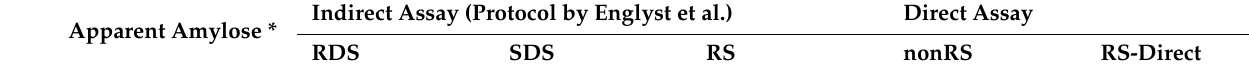
Table 3. Lentil total starch, apparent amylose content, and starch fractions (%, dry weight basis). Color / Class /